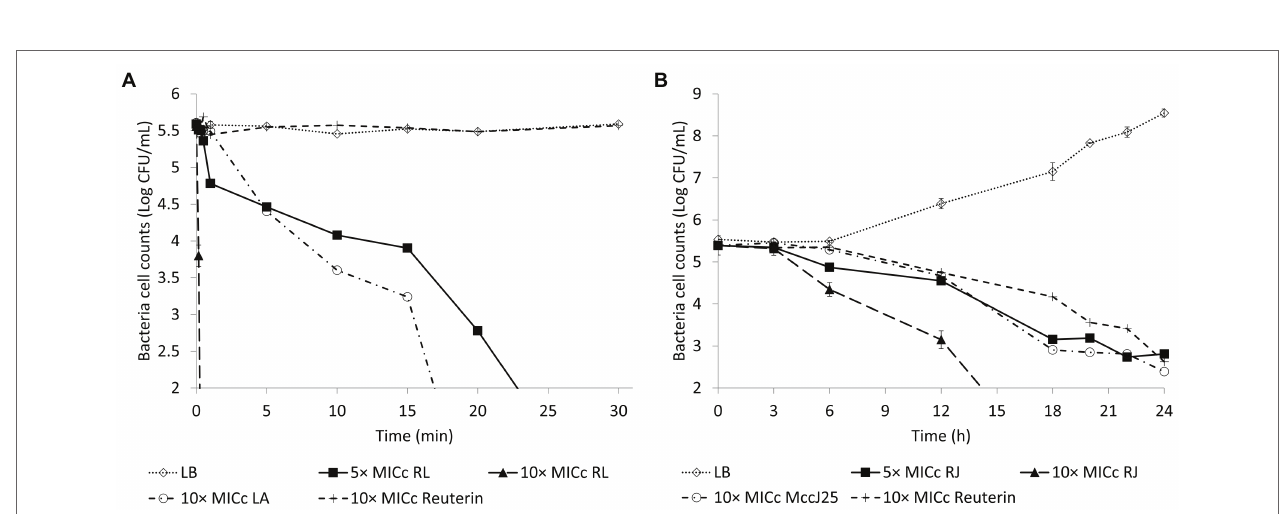
FIGURE 3 | Survival of Salmonella Enteritidis MNHN at room temperature after exposure to (A) reuterin, lactic acid (LA), and reuterin + LA (RL); or (B) reuterin, microcin J25 (MccJ25), and reuterin + MccJ25 (RJ) at 5 or 10 times minimum inhibitory concentrations in combination (MICc). Bars indicate standard